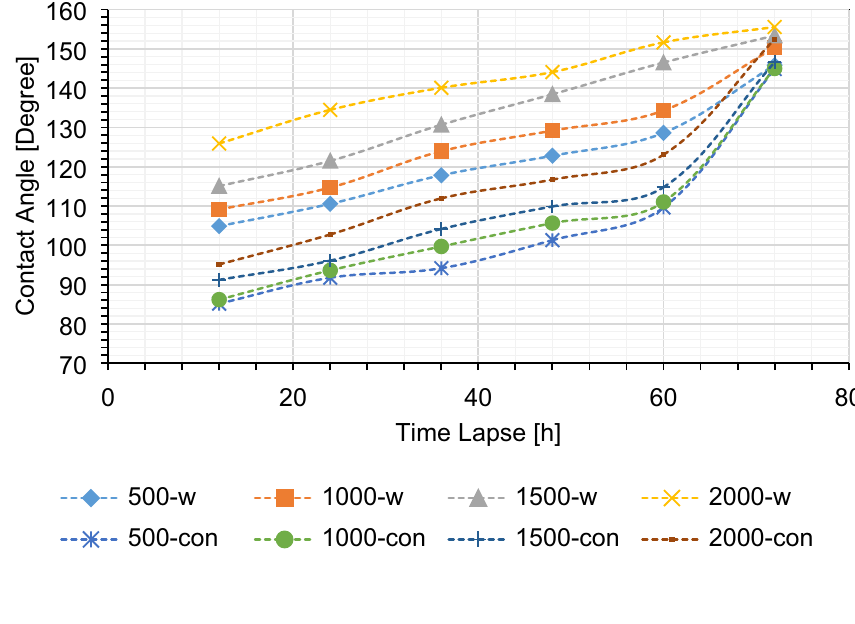
Fig. 8 The obtained curves from the contact angle experiments due to the droplet of water and condensate in the presence of the hydrocarbon gas on the aged carbonate sections of R134A gas at 70 °C and different pres- sures of aging